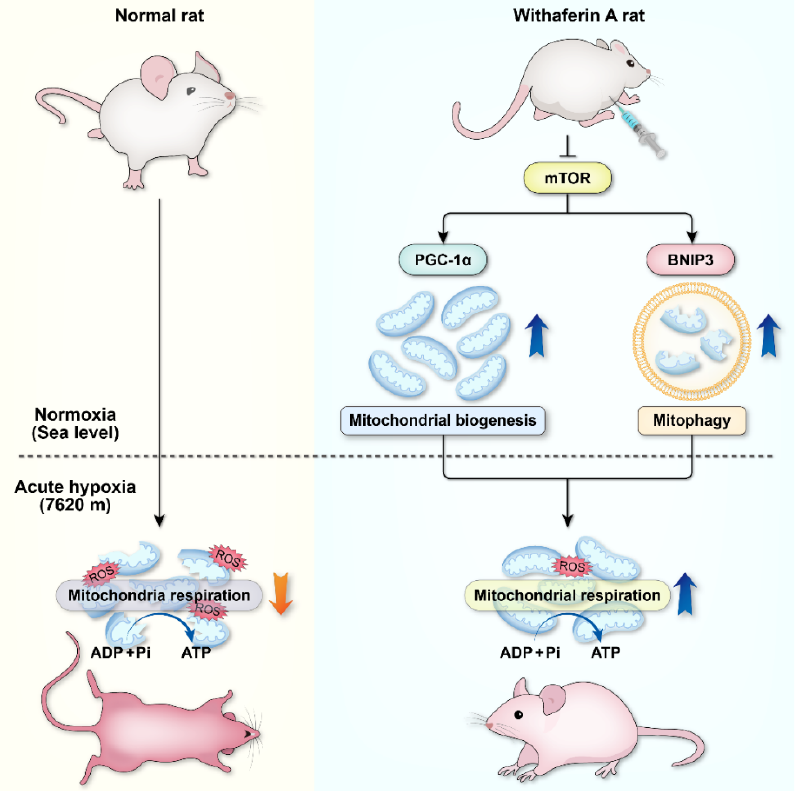
Figure 9. Schematic diagram illustrating that withaferin A pretreatment enhances the adaptability to extreme hypoxia by enhancing PGC-1 α -mediated mitochondrial biogenesis and BNIP3-mediated mitophagy. Normal SD rats have difficulty surviving in the extreme hypoxic environment due to mitochondrial damage and insufficient ATP supply. Withaferin A pretreatment can significantly improve survival in rats in extremely hypoxic environments. Taken together with our previous study [30], the upstream regulator, mTOR, plays an important role in regulating these two pathways. By inhibiting the mTOR, on the one hand, WA enhances the BNIP3-mediated mitophagy, which eliminates hypoxia-damaged mitochondria and prevents the induction of apoptosis. On the other hand, WA promotes the PGC-1 α -mediated mitochondrial biogenesis, which can supplement functional mitochondria and maintain mitochondrial respiration to ensure mitochondrial ATP production under acute extreme hypoxia. These two complementary pathways, mitophagy and mitochondrial biogenesis, improve the body’s ability to rapidly adapt to extremely hypoxic environments.